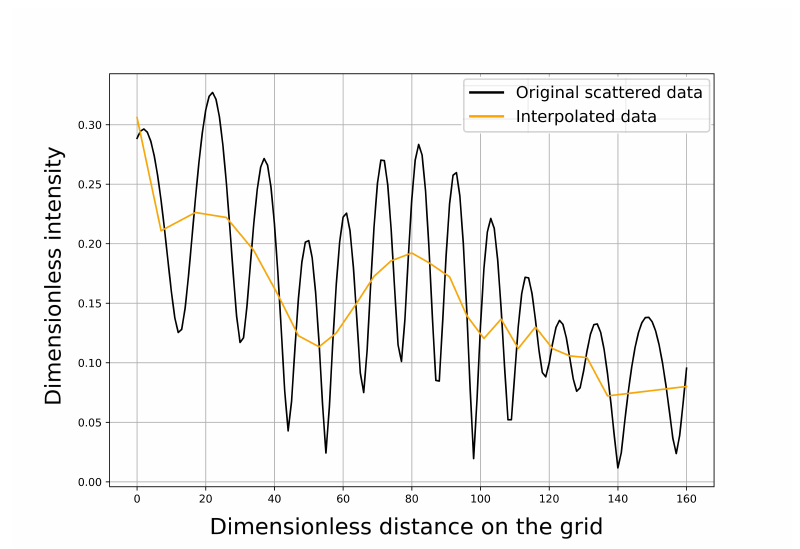
Figure 3. Sample row simulation data (without noise) and the interpolated